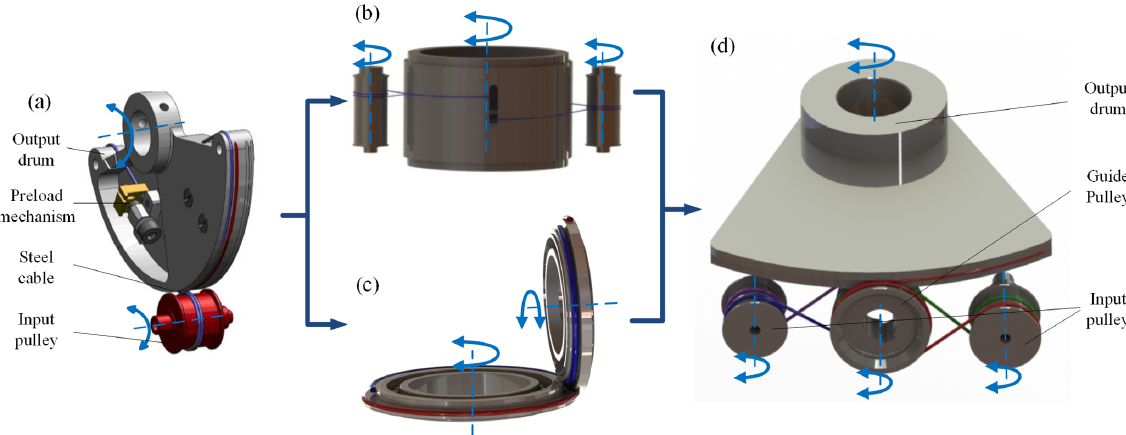
Figure 1. Development of the proposed transmission configuration: (a) the SISO spur gear configuration (cited in Lu and Fan, 2013); (b) the MISO configuration; (c) Bevel gear configuration; (d) a combination of MISO and bevel gear transmission